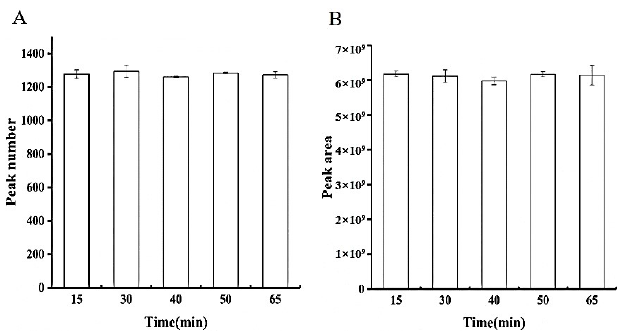
Figure 4. Histogram of the number of peaks and peak areas with different ultrasound times. ( A ) Total number of peaks of the flue-cured NTL leaves extracted with different ultrasound times; ( B ) total number of peak areas of the leaves extracted with different ultrasound times.